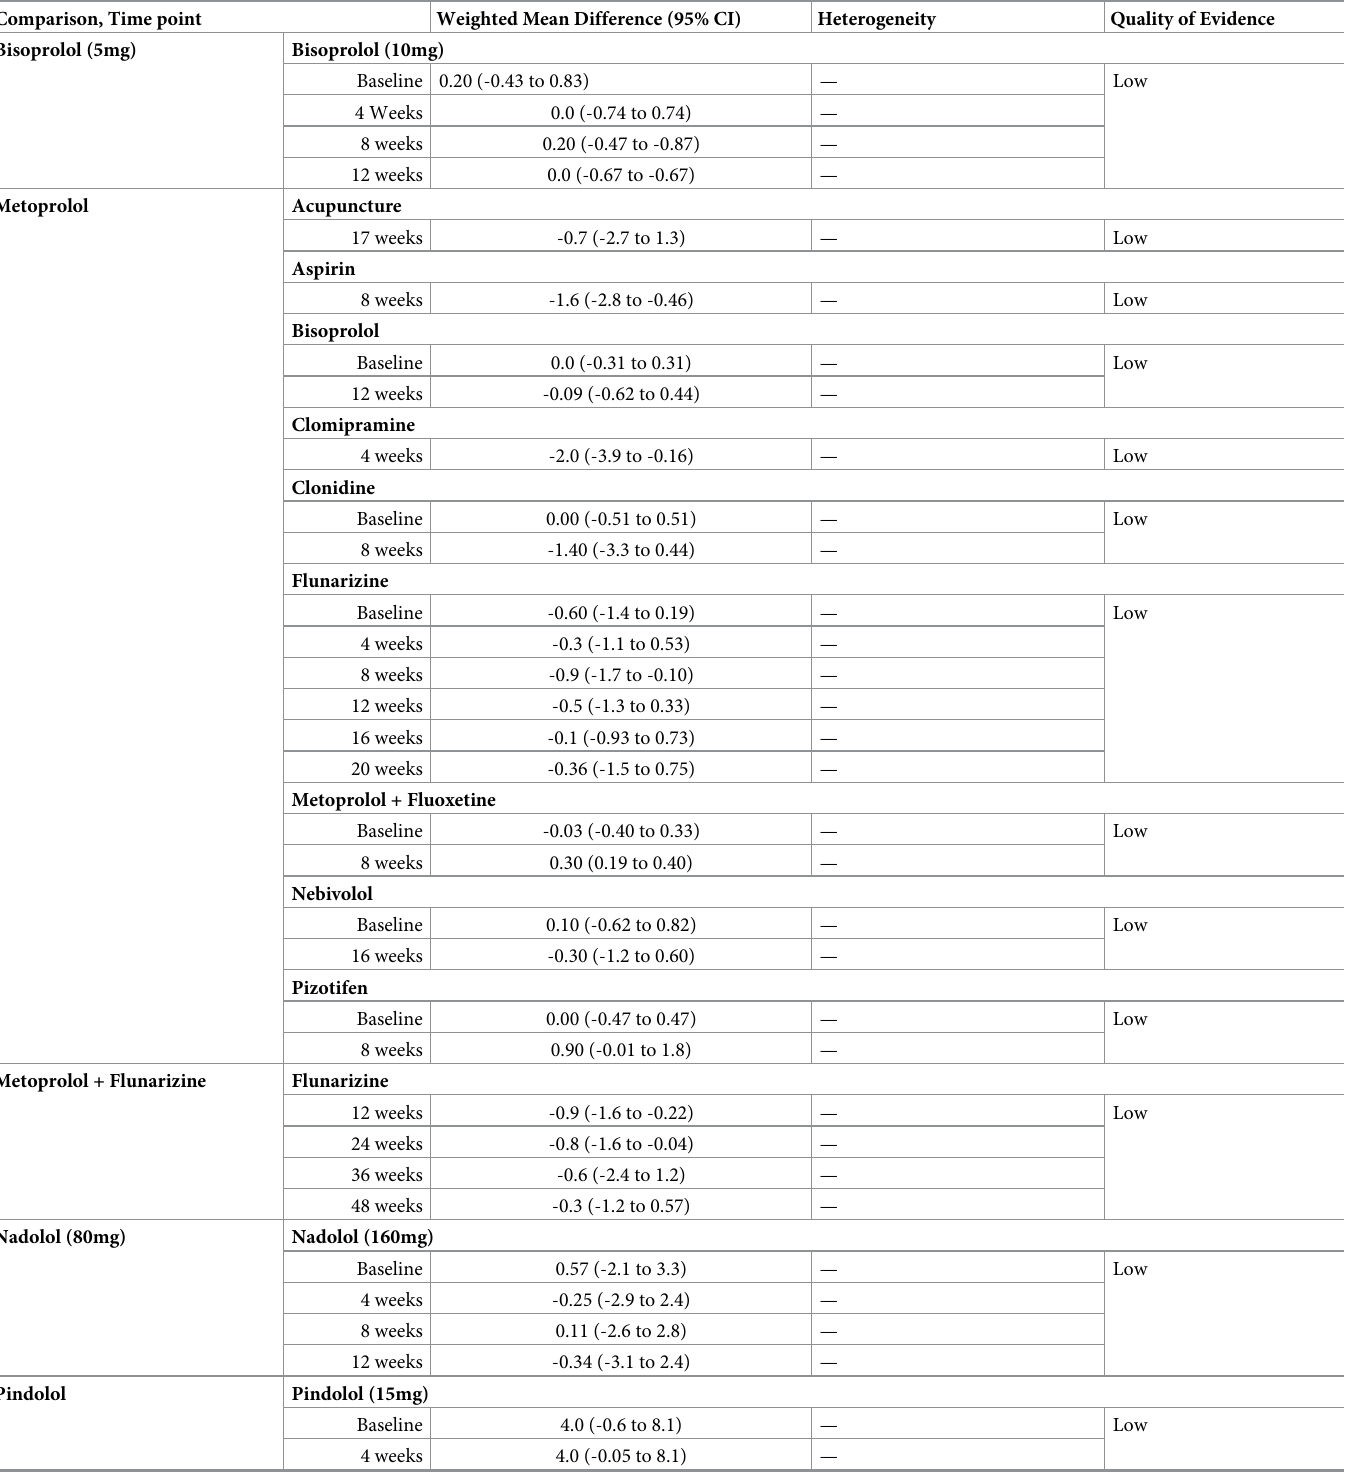
Table 4. Primary outcome (headache frequency) of comparative effectiveness